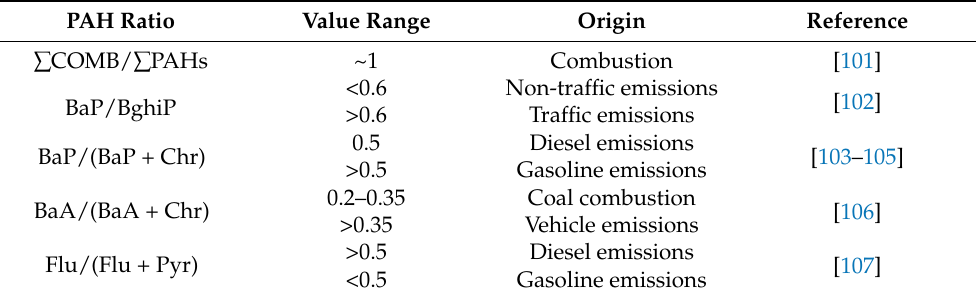
Table 6. Characteristic ratios of PAHs used for source identification.